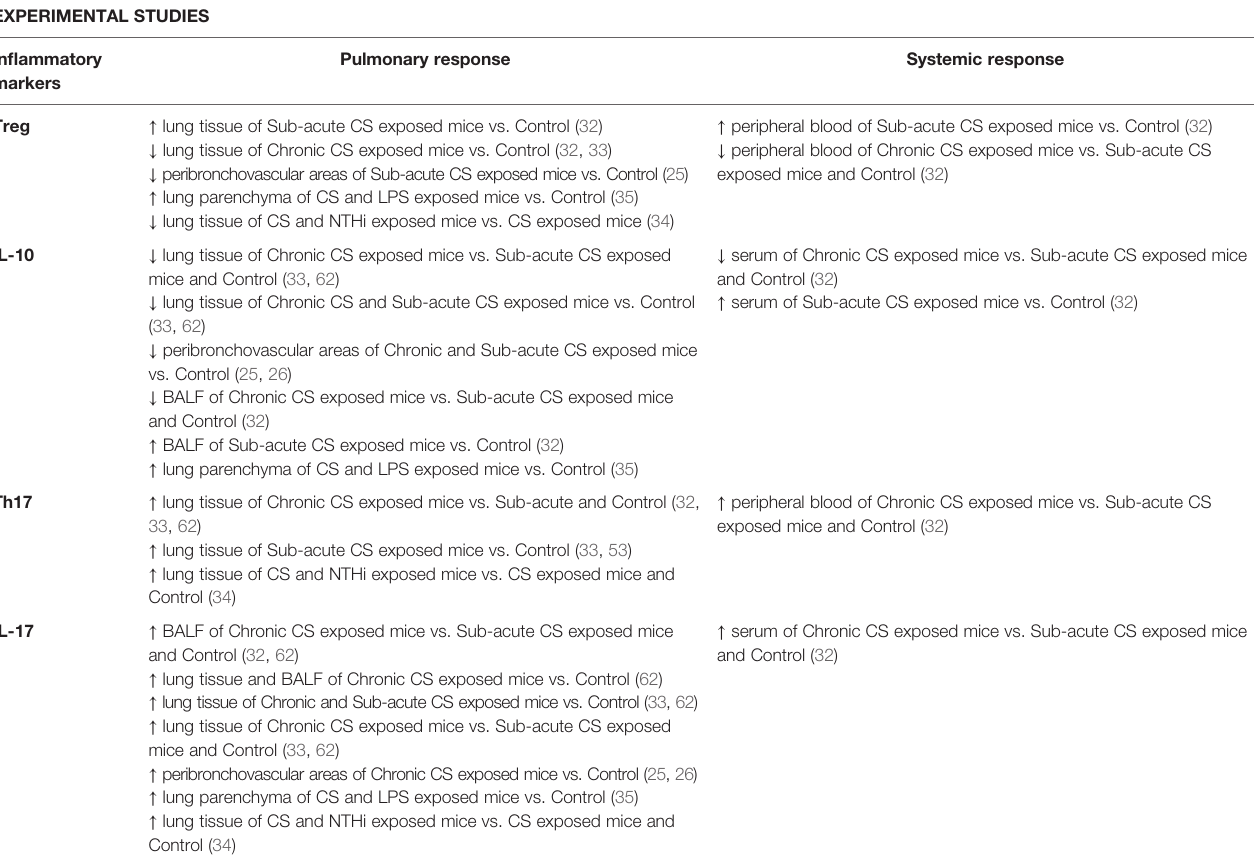
TABLE 2 | Summary of the main fi ndings regarding Th17/Treg imbalance in experimental studies. EXPERIMENTAL